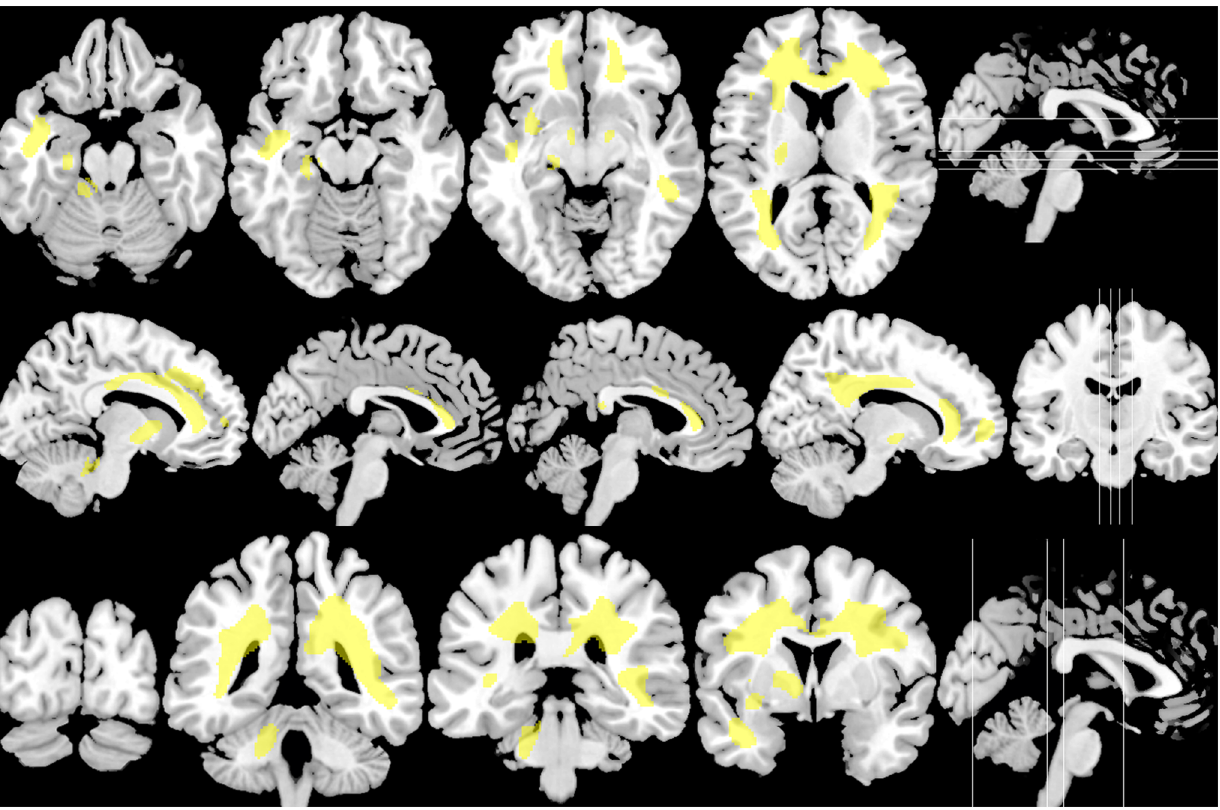
Figure 2. Brain perfusion positive correlation with the number of optic neuritis attacks in RNMO patients. The same slices as shown in Figure 1, presenting the perfusion positive correlation statistical parametric map, which was found in an extensive brain area mainly located in the white matter. Note that perfusion changes included periventricular areas. Statistical parametric map was thresholded at p value , 0.01 (p value , 0.05 corrected for multiple comparisons at the cluster level).